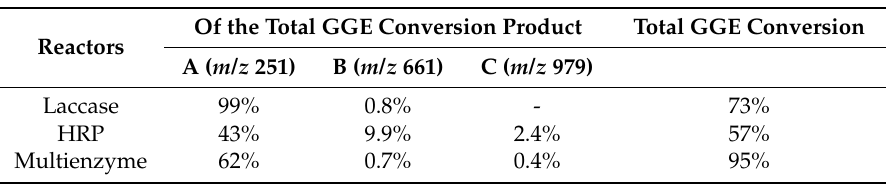
Table 1. Conversion of GGE to different oxidation